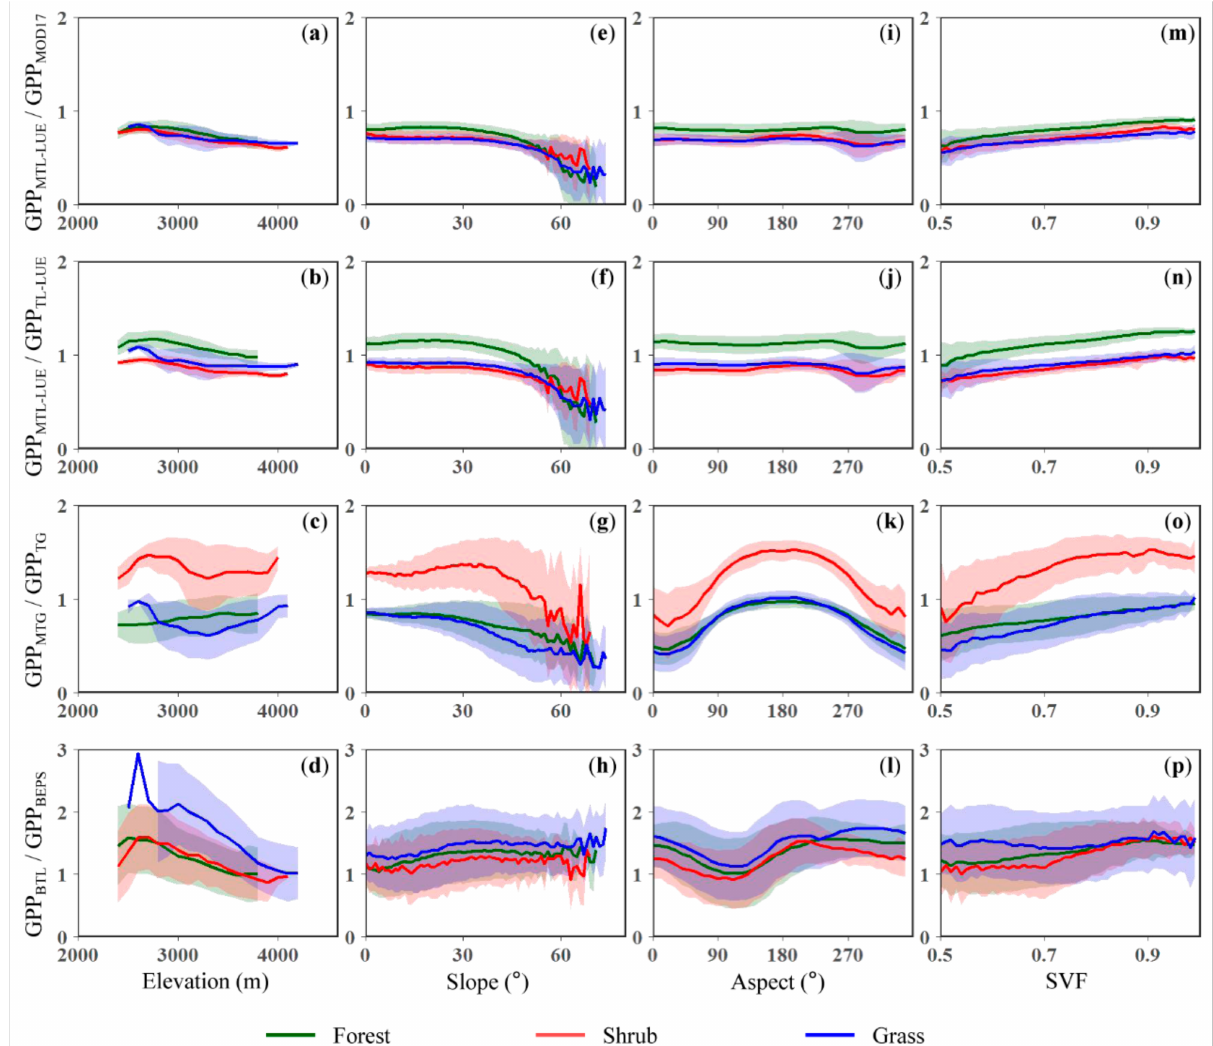
Figure 6. Relationships between annual GPP estimates and elevation ( a – d ), slope ( e – h ), aspect ( i – l ), and SVF ( m – p ). The first to the forth row indicate the GPP MTL-LUE /GPP MOD17 , GPP MTL-LUE /GPP TL-LUE , GPP MTG /GPP TG , and GPP BTL /GPP BEPS , respectively. For each vegetation type in the subfigure, the solid line and ribbon represent the mean and standard deviation values in each elevation (calculated at the interval of 100 m), slope (calculated at the interval of 1 ◦ ), aspect (calculated at the interval of 10 ◦ ), and SVF (calculated at the interval of 0.01)